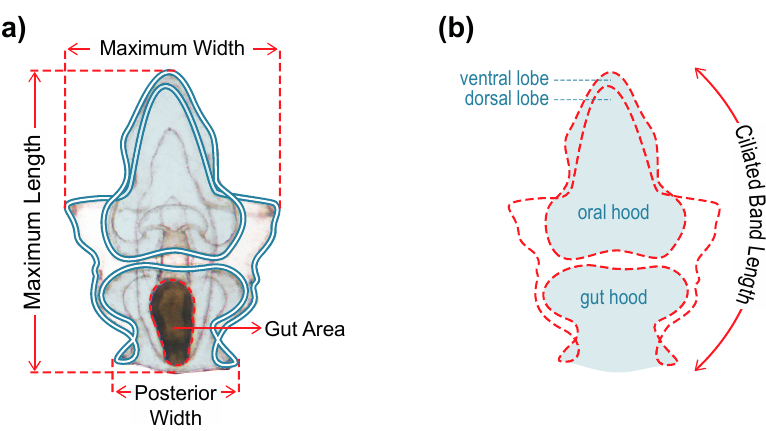
Figure 1. Morphometric measurements of larvae taken four and ten days after commencement of feeding: ( a ) size of morphological features; ( b ) Ciliated band length = sum of the traced perimeter measurements of the oral hood and ventral lobe, gut hood, larval sides, and dorsal lobe (red dashed outline).